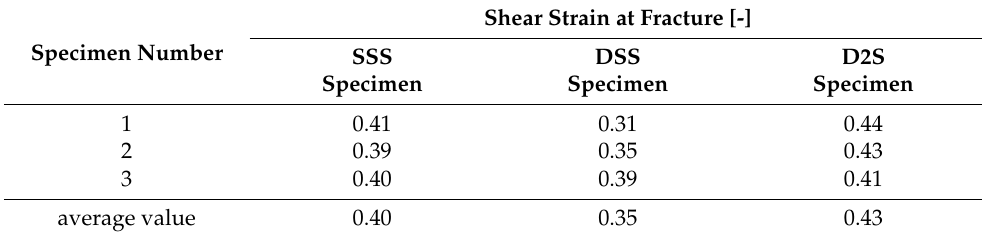
Table 1. Values of shear strain at fracture depending on the specimen geometry.